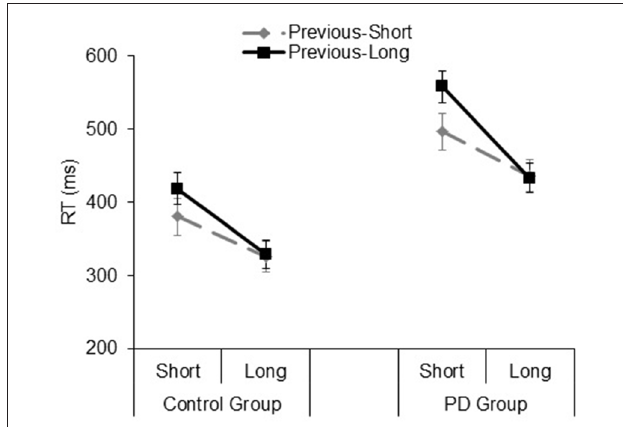
FIGURE 5 | Mean reaction time (RT) plotted as a function of Previous Foreperiod (previous-short, previous-long) and Current Foreperiod (short, long) in the Control group and PD group. Error bars represent the standard error of the mean.